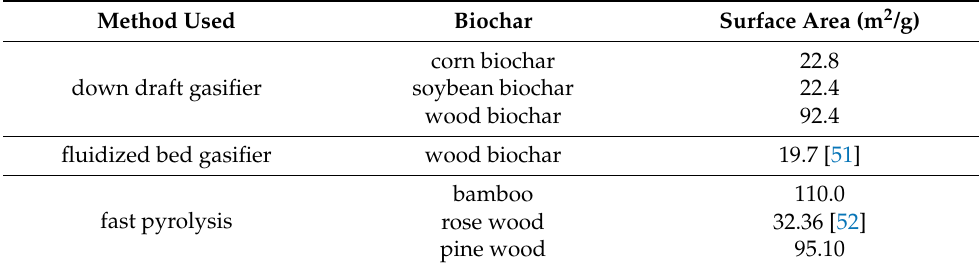
Table 4. Surface area of biochar and comparison to other